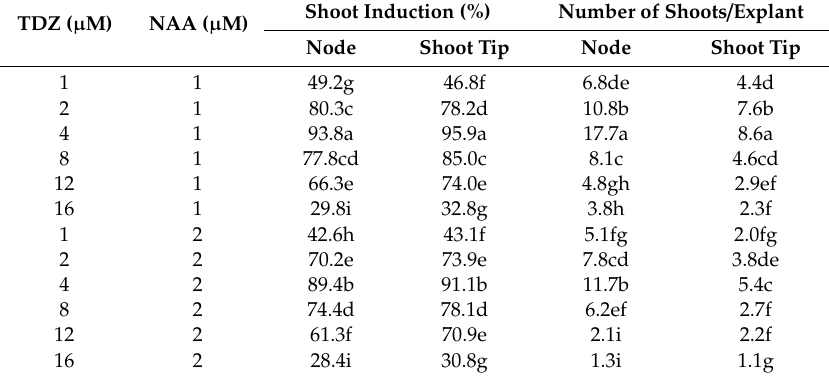
Table 2. E ff ects of the combination of TDZ and NAA on multiple shoot induction from the node and shoot tip explants of Mertensia maritima